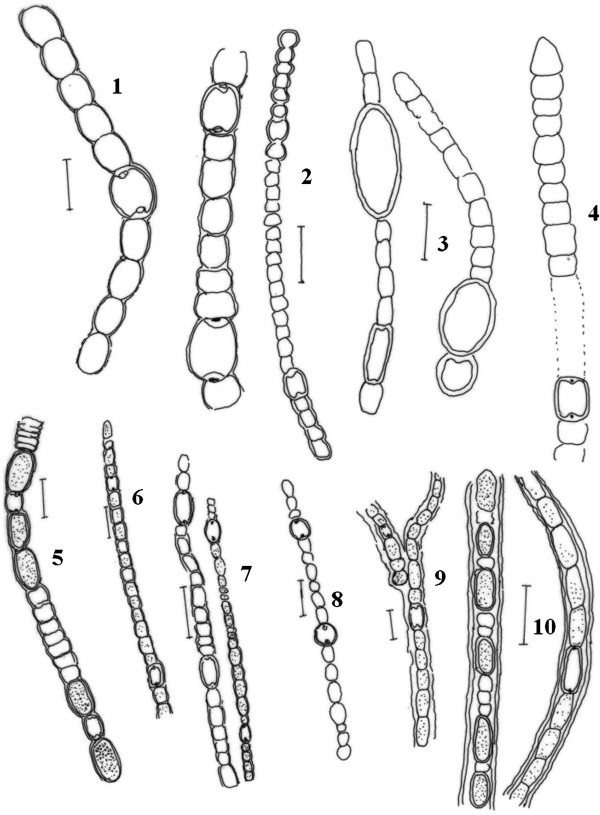
Camera Lucida diagram, of cyanobacterial species 1. Anabaena azollae2.  Anabaena fertilissima 3. Anabaena marcospora 4. Anabaena orientalis 5. Anabaena oscillarioides6. Anabaena sphaerica7. Anabaena variabilis8. Anabaena iyengarri9. Aulosira fertilissima10. Aulosira bombayensis. Scale bar 10 μm.